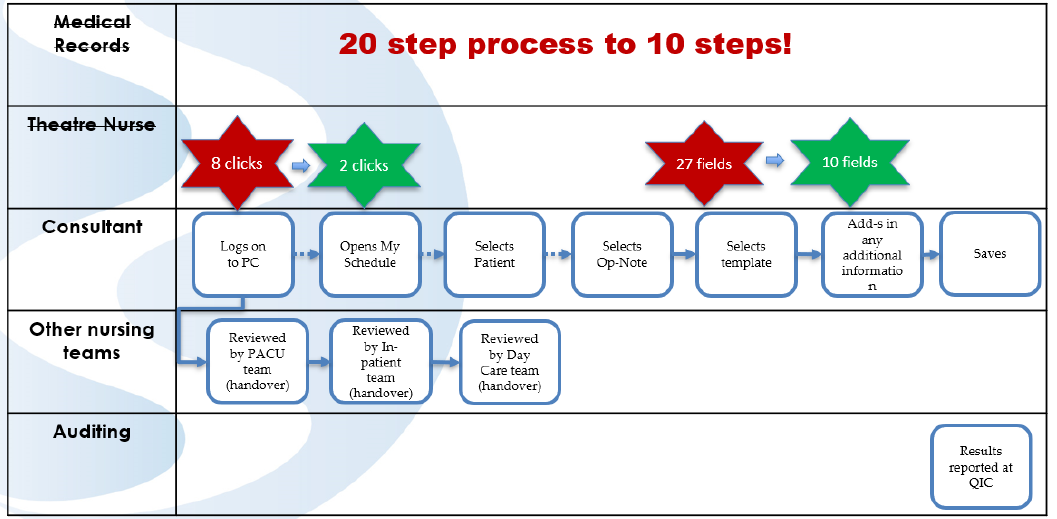
Figure 8. “As it should be” process map .